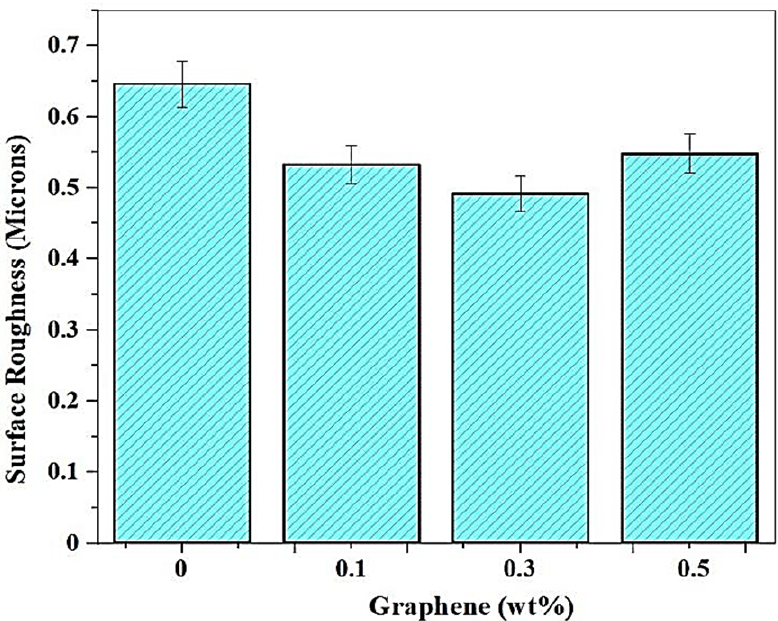
Figure 15. Variation of Surface Roughness with the addition of Graphene. Figure 15 . Variation of Surface Roughness with the addition of Graphene .